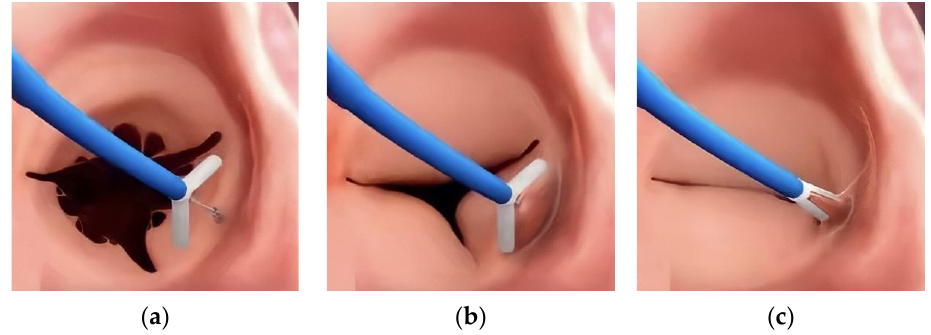
Figure 2. The main steps of K-Clip ™ implantation. ( a ): The opening clamp and the tapping screw-shaped anchor; ( b ): the tapping screw-shaped anchor is inserted into the middle of the posterior TA and pulled back to bring the surrounding annular tissue into the clamp; ( c ): the clamp is closed to plicate the TA and achieve bicuspidization of the TV.